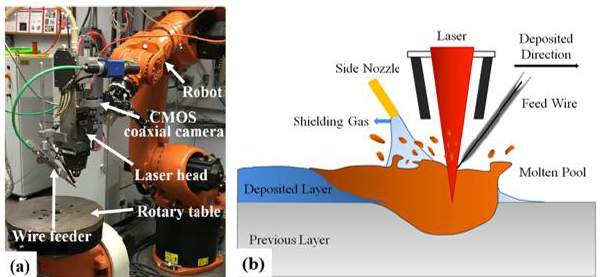
Figure 1. ( a ) Wire laser additive manufacturing system [13] and ( b ) schematic diagram.